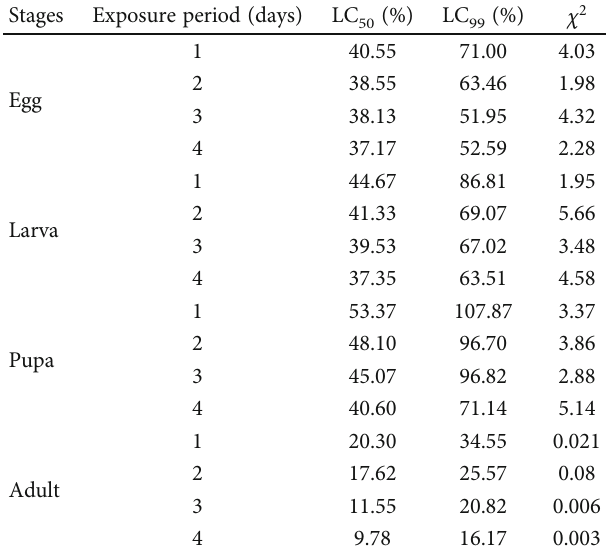
concentration and (b) 60% CO concentration. 2 2 Table 1: Probit analysis of CO concentrations on di ff erent life 2 stages of mortality of Callosobruchus maculatus